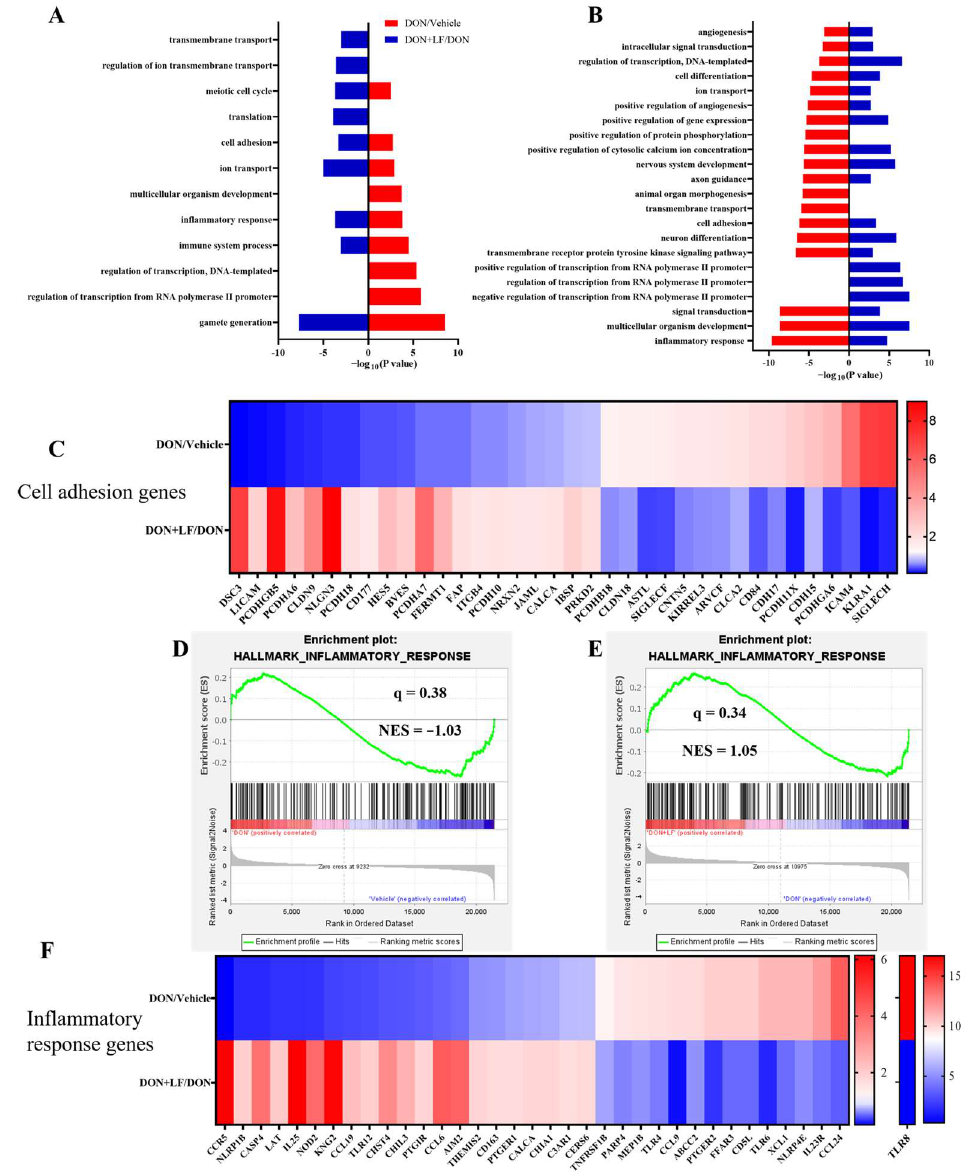
Figure 5. Transcriptional profiling of testes from mice, with diet supplementation of DON and LF. Gene ontology (GO) analysis of the up-regulated genes of the DON group compared to those of the vehicle group coupled with down-regulated genes of the DON + LF group compared to those of the DON group ( A ) and down-regulated genes of the DON group compared to those of the vehicle group coupled with up-regulated genes of DON + LF group compared to those of the DON group ( B ). Hypergeometric testing and Benjamini–Hochberg p value correction were applied. Heatmap of mRNA expression (RNA-seq) changes of the cell adhesion genes ( C ) and inflammatory response genes ( F ) in the testes of DON and LF-treated mice. ( D , E ) GSEA plots depicting the enrichment of genes involved in the inflammatory response of testes from DON-treated mice compared to the vehicles and DON-LF co-treated mice compared to the DON-treated mice. NES, normalized enrichment score; q value indicates false discovery rate p value (same for Figure